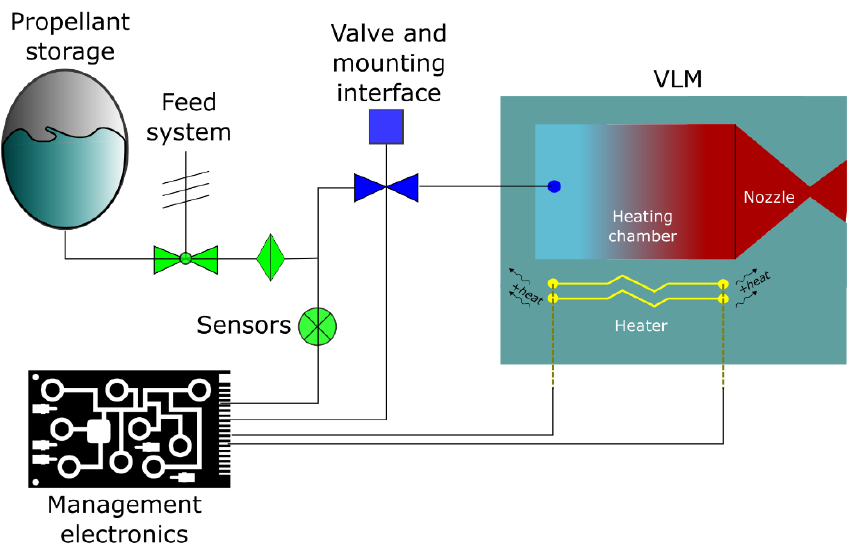
Figure 1. Schematic of a typical VLM system, including the feeding system components (green) and the thruster components (blue) (reproduced from [1]).